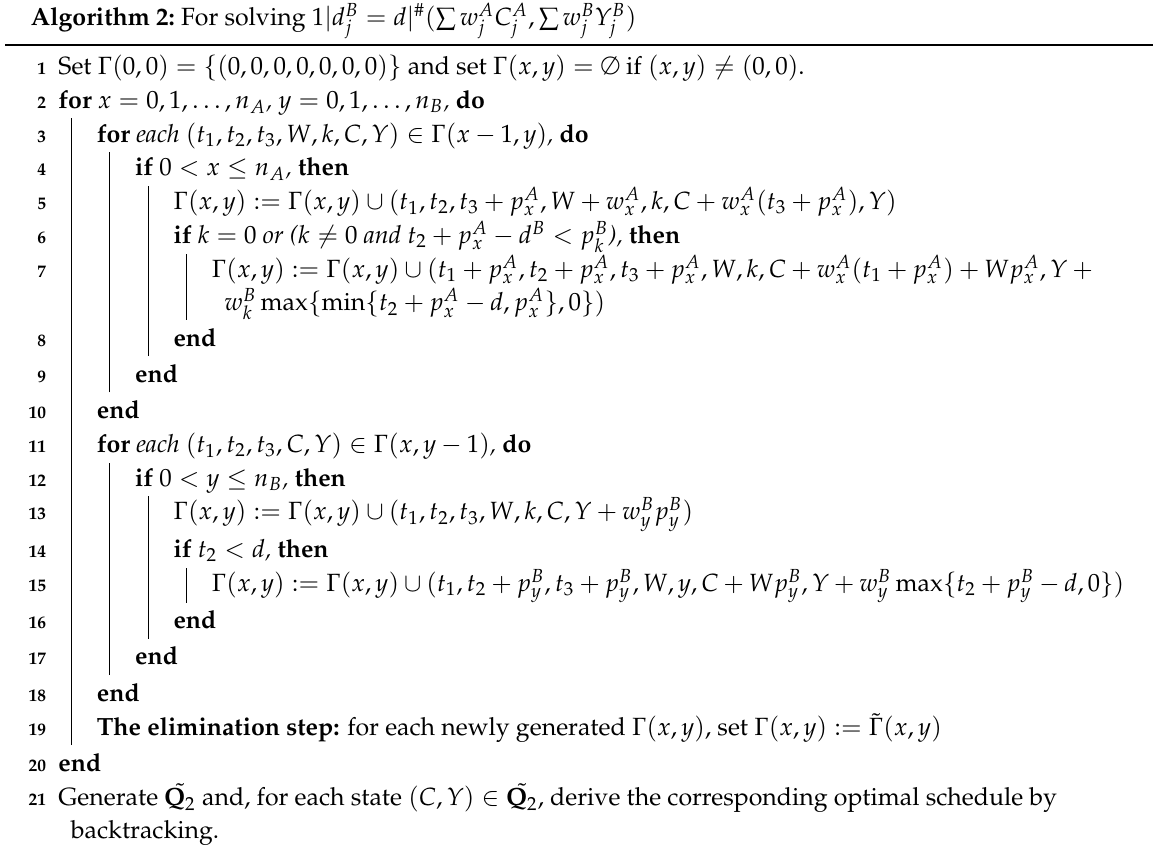
C A Y B , ∑ w B j j j j